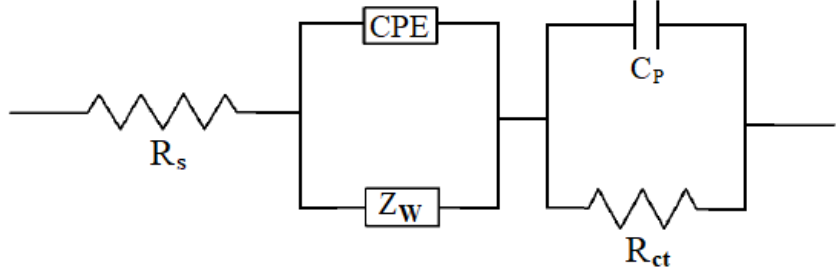
Table 4. Electrochemical impedance spectroscopy (EIS) parameters that were determined for the GCE electrode that was modified with the functionalized and non-functionalized CNOs.